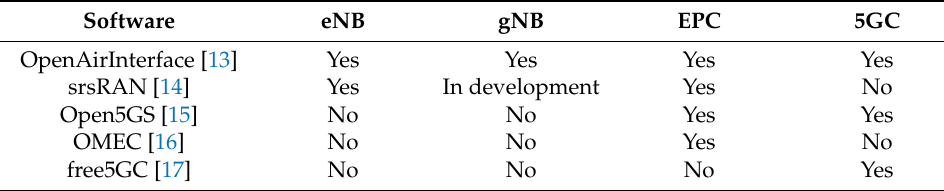
Table 1. Available open source solutions for mobile networks using